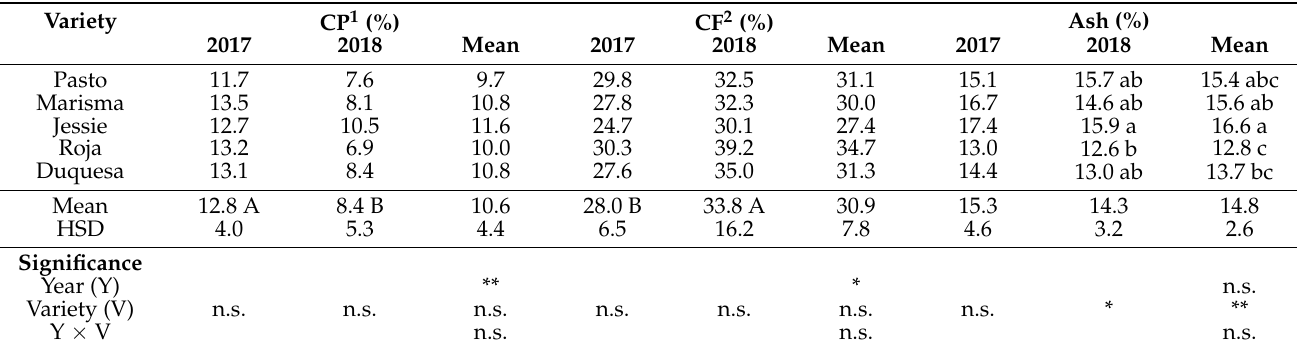
Table 1. Crude protein (CP), crude fiber (CF), and ash content (%) of straw of five quinoa varieties during the two years (2017 and 2018) of field experiments. Variety CP 1 (%) CF 2 (%) Pasto